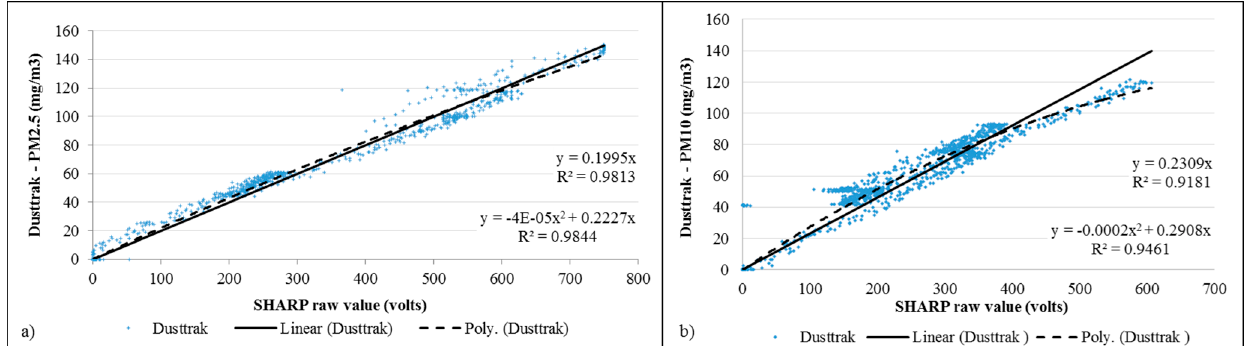
Figure 7. Correlation of raw values obtained with SHARP sensor for ( a ) PM2.5 and ( b ) PM10 vs . readings collected with Dusttrak (mg/m 3 ).